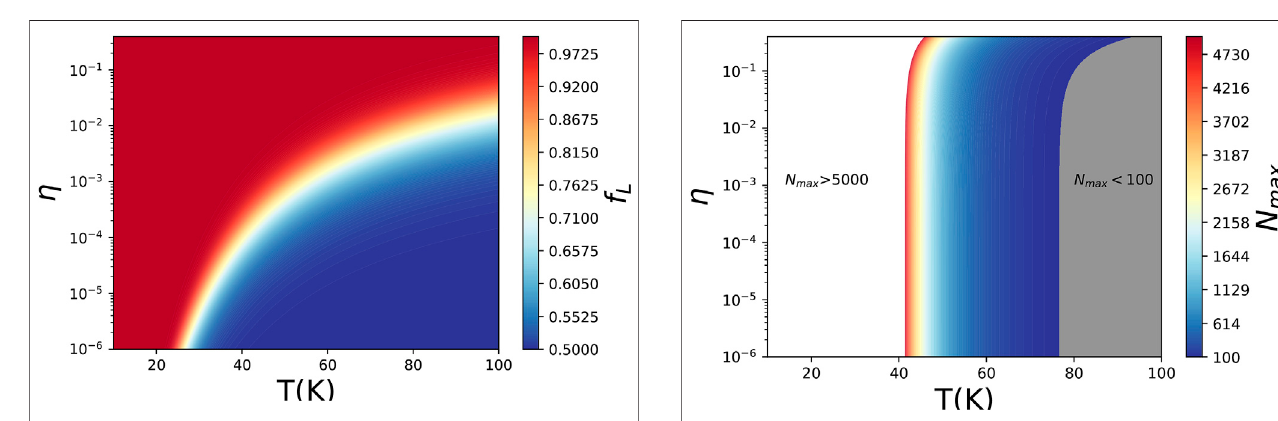
FIGURE 1 | Probability of L-type monomer in the polymer chain. FIGURE2| Dependence ofthemaximumpure L-type chainlength Non η and